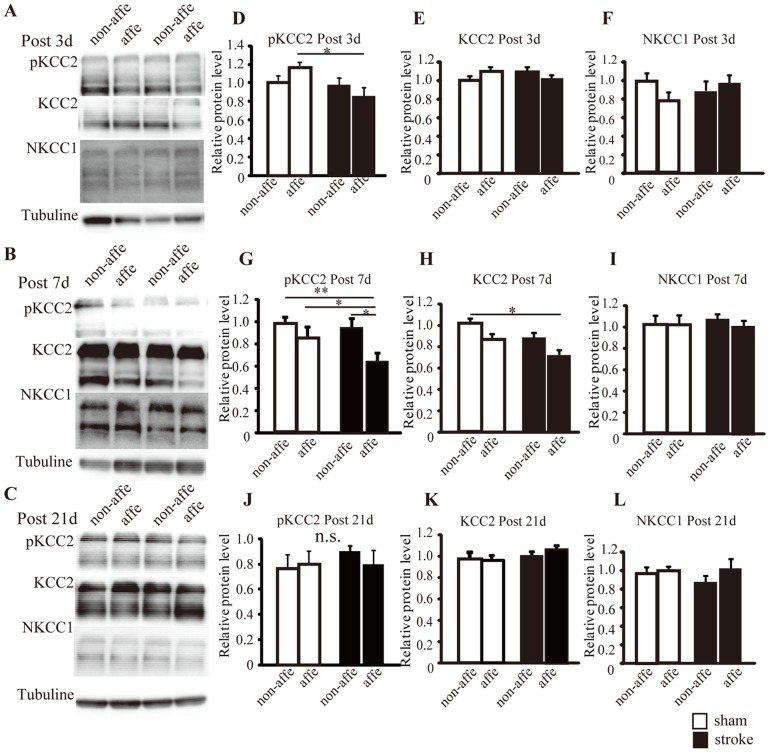
KCC2, S940 phosphorylation in KCC2, and NKCC1expression levels assessed by western blot analysis in membrane-enriched fractions of the ventral horn.A, B, and C: At 3, 7, and 21 d post-stroke, bands of KCC2, phosphorylated S940, NKCC1, and tubulin. D-L: Quantification analysis of KCC2, phosphorylated S940, NKCC1levels at 3, 7, and 21 d after stroke. White bars are sham animals, and black bars are stroke animals. Data are presented as relative ratio to the mean sham non-affected and as the mean ± S.E.M. One-way ANOVA post hoc test Tukey-Kramer tests: *p<0.05, **p<0.01.